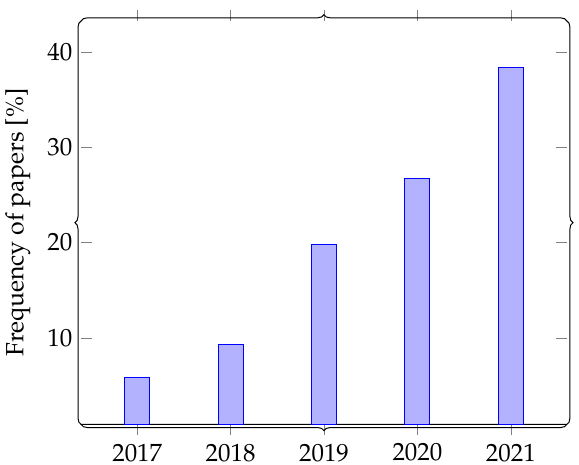
Figure 2. Time trend of reported assessment